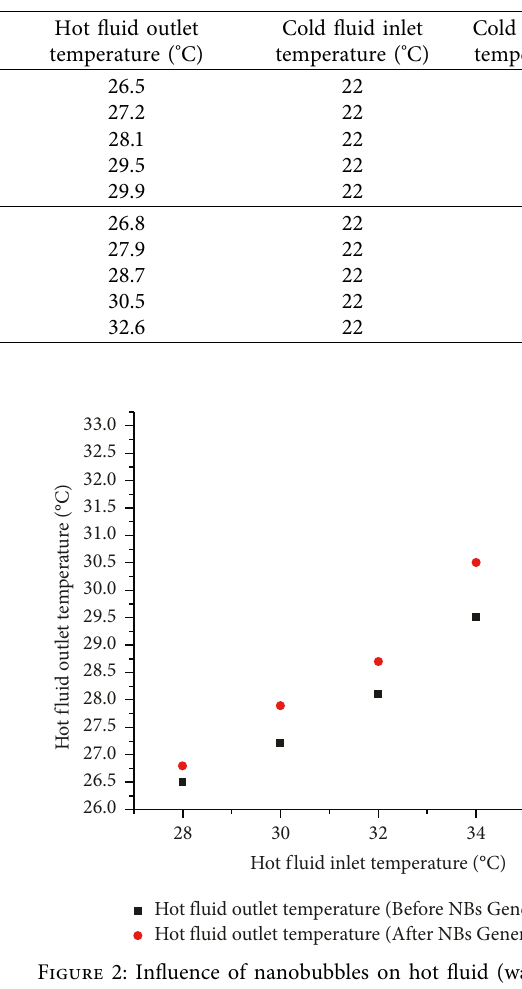
Figure 1: Equipment for nanobubble generation. Table 1: Temperature difference between hot and cold fluids.